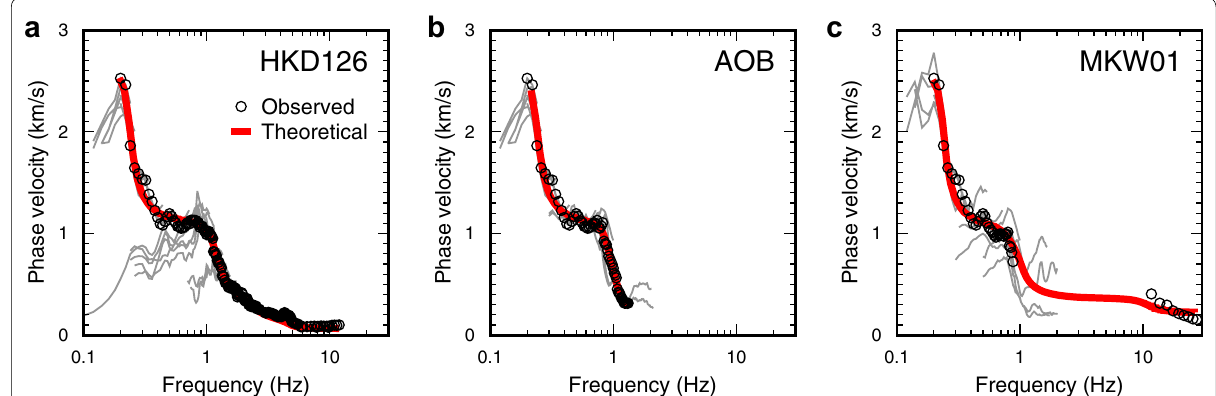
Fig. 10 Observed and theoretical phase velocities of the Rayleigh waves at three sites. The black circles denote the observed phase velocities. The red solid line denotes the theoretical phase velocities for the estimated V s structure model. a HKD126, b AOB, c MKW01. The gray solid lines denote the original observed phase